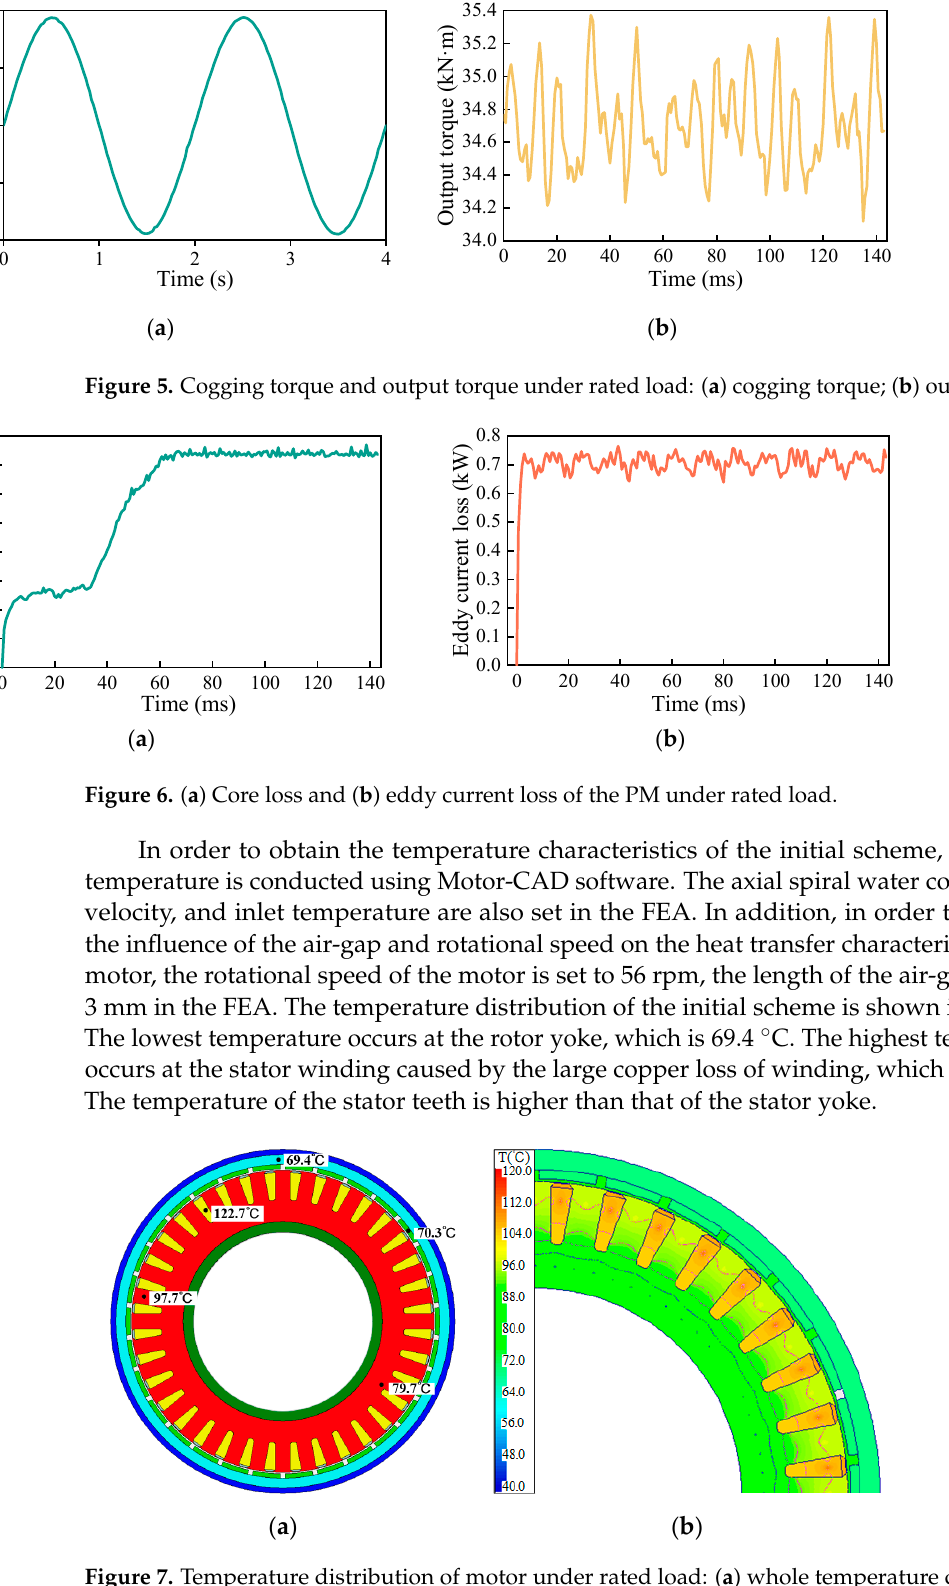
Figure 7. Temperature distribution of motor under rated load: ( a ) whole temperature distribution; ( b ) partial temperature distribution.